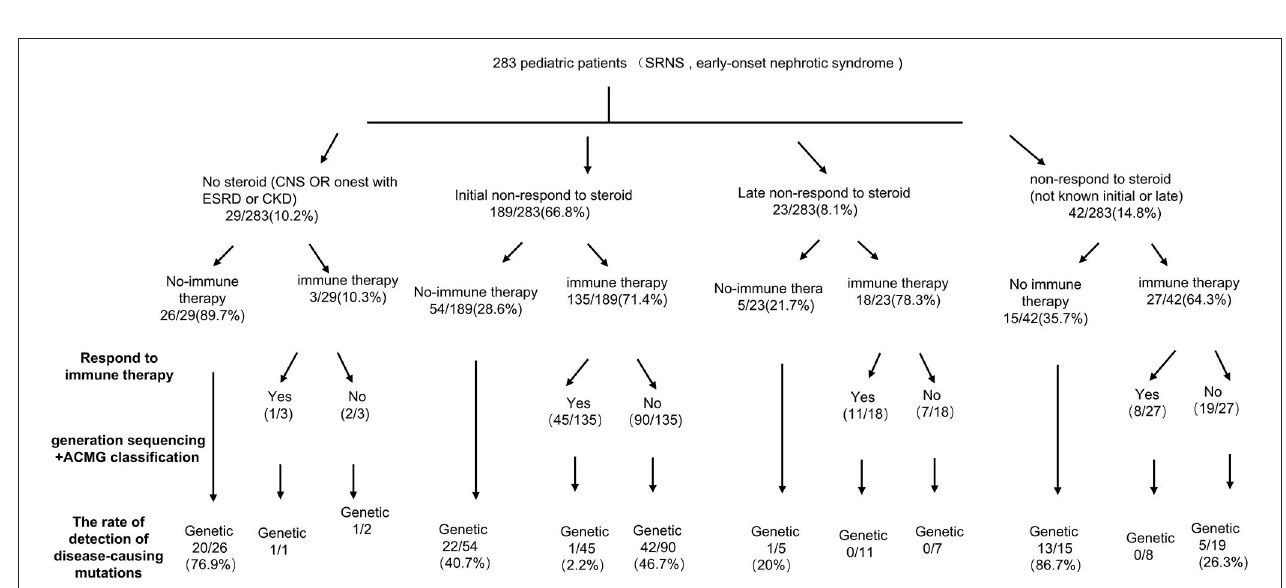
FIGURE 1 | Flow chart of patients by phenotype at presentation, age, and genetic diagnosis.